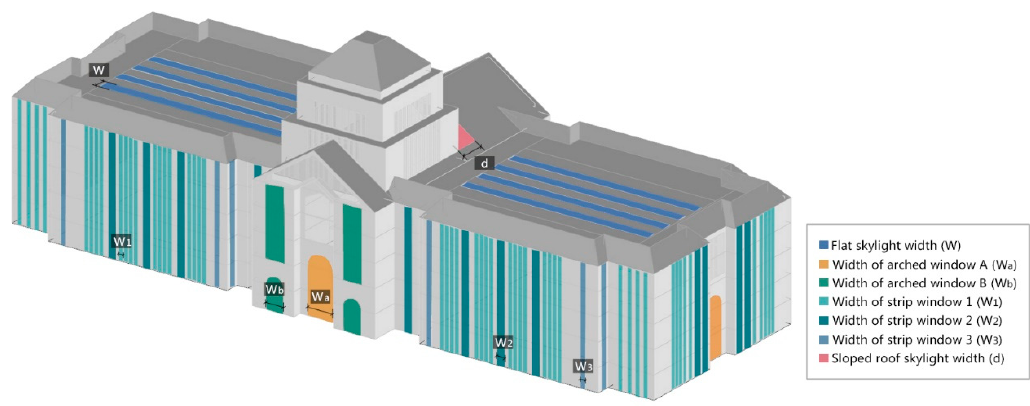
Figure 4. The variables related to windows and skylights.